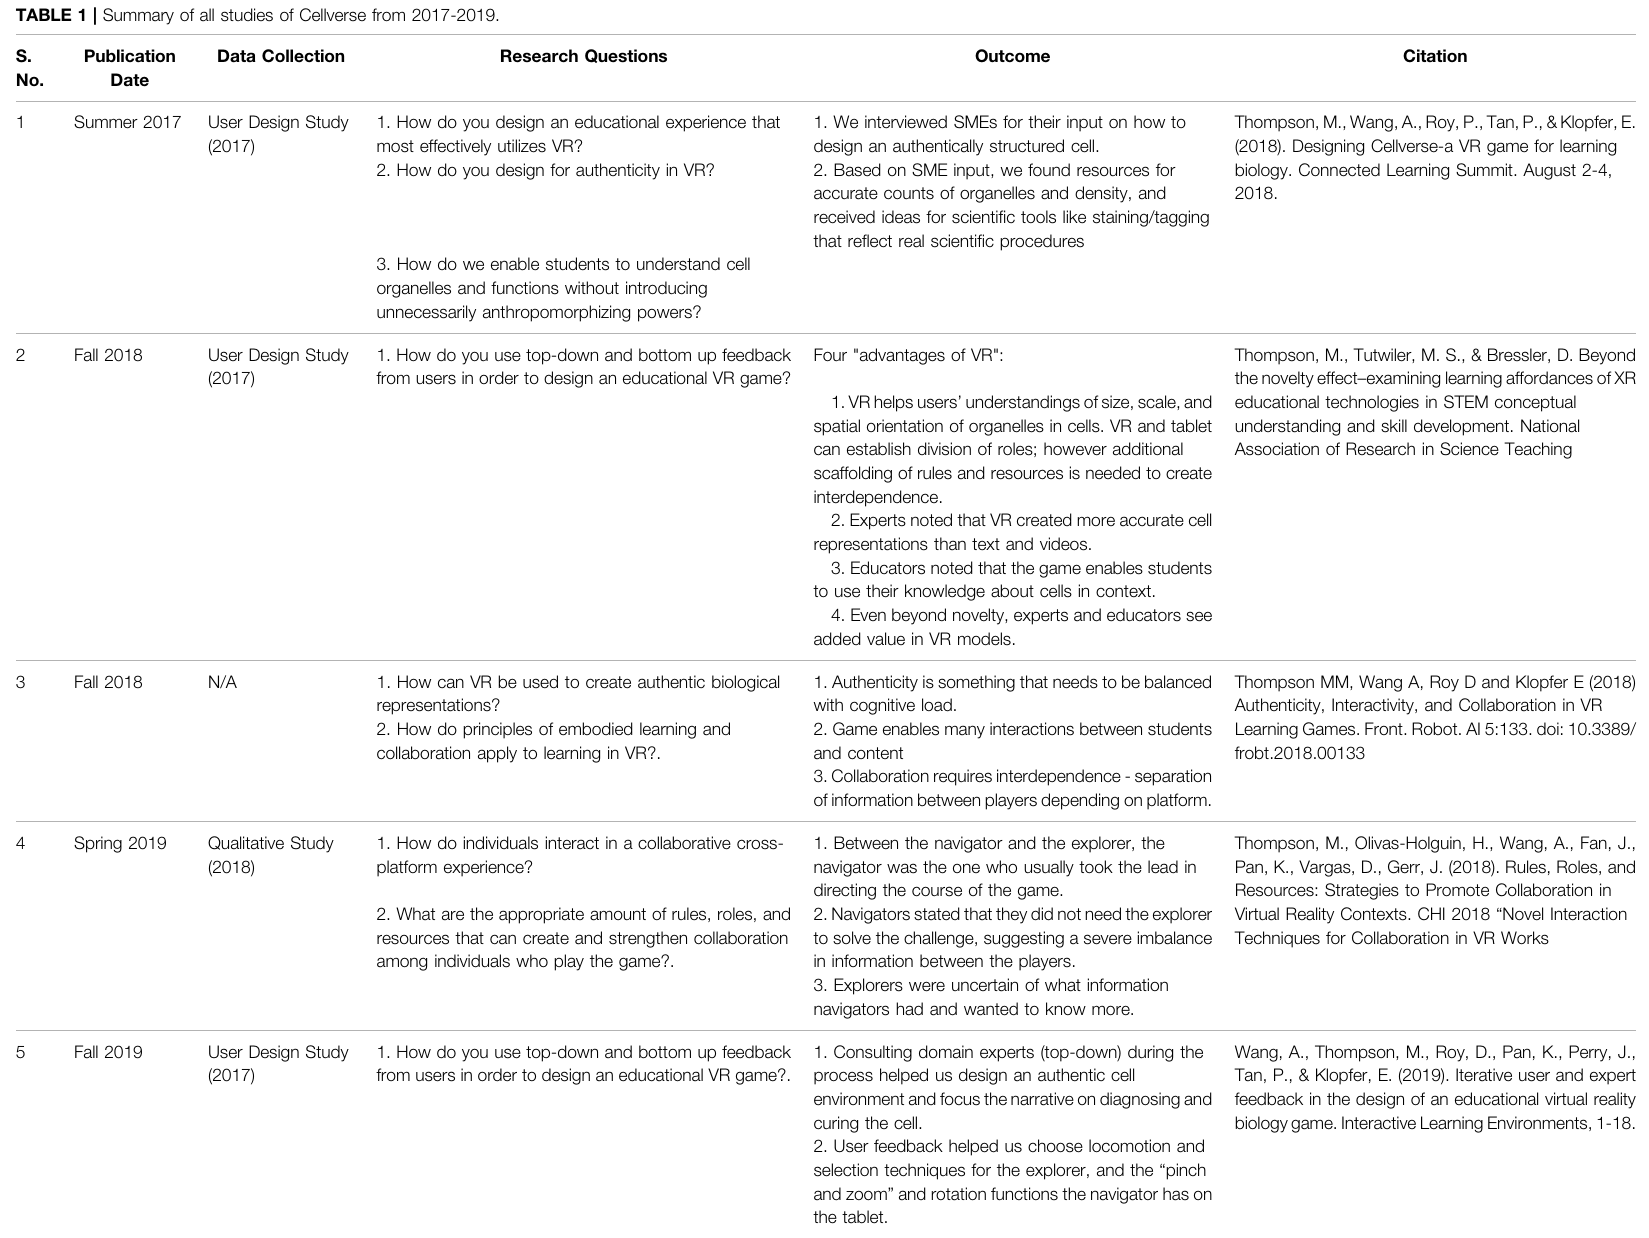
TABLE 1 | Summary of all studies of Cellverse from